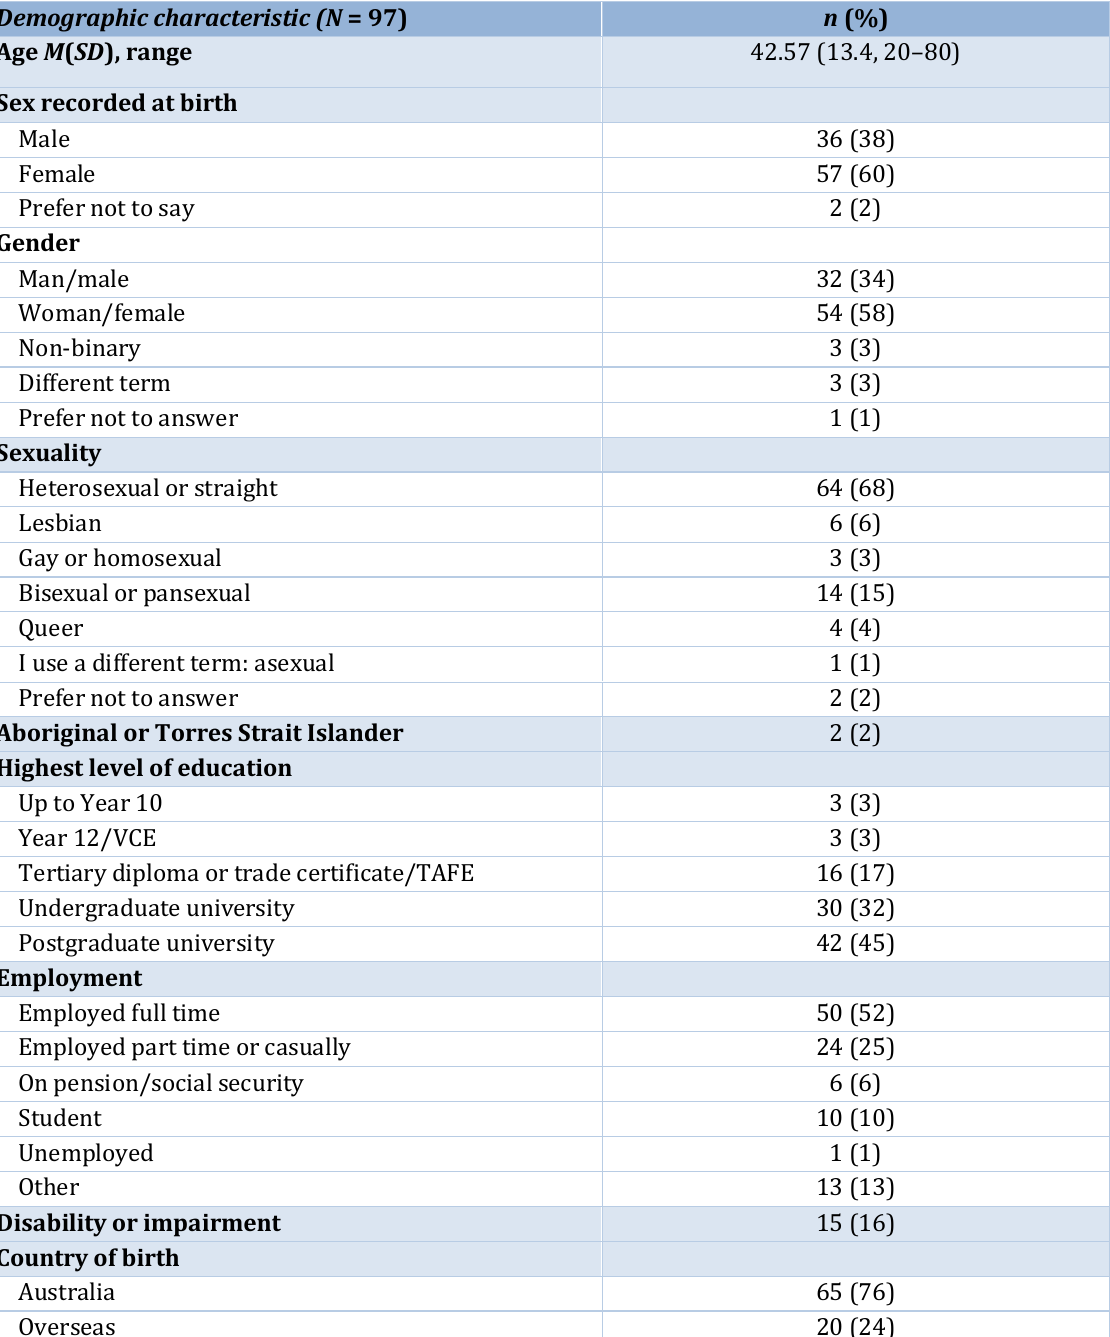
Table 1: Demographic characteristics of the survey sample Demographic characteristic (N =